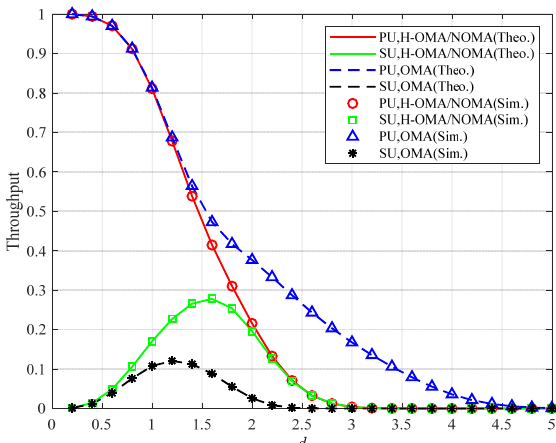
Figure 7. Throughput vs distance factor.